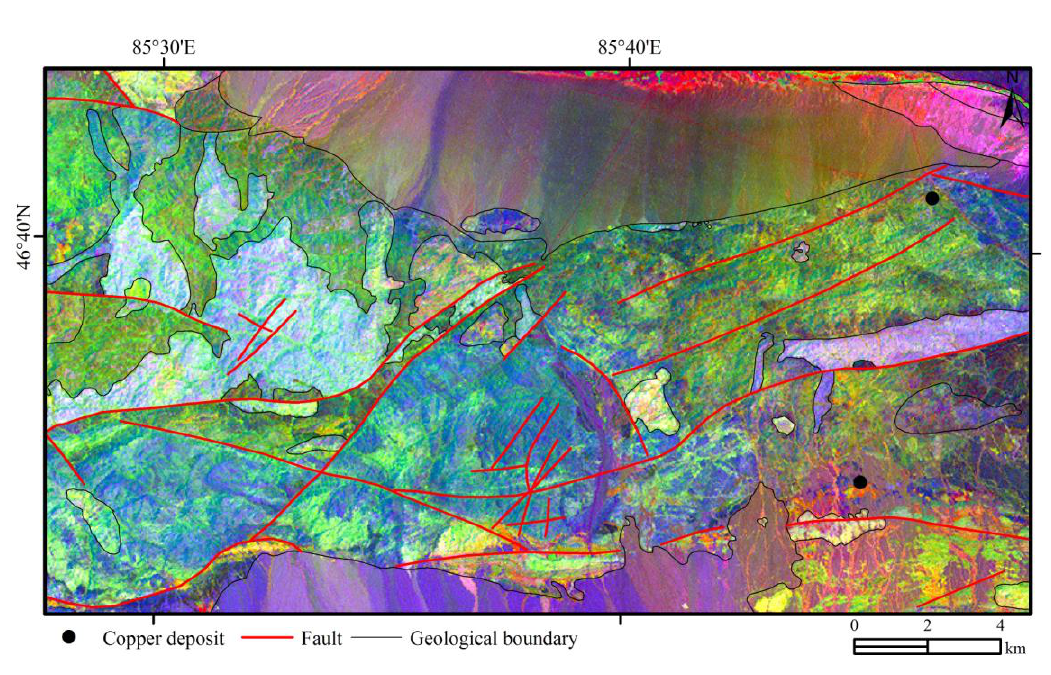
Figure 2. Principal components analysis (PCA1, PCA2, and PCA4 in the RGB) image of ETM+